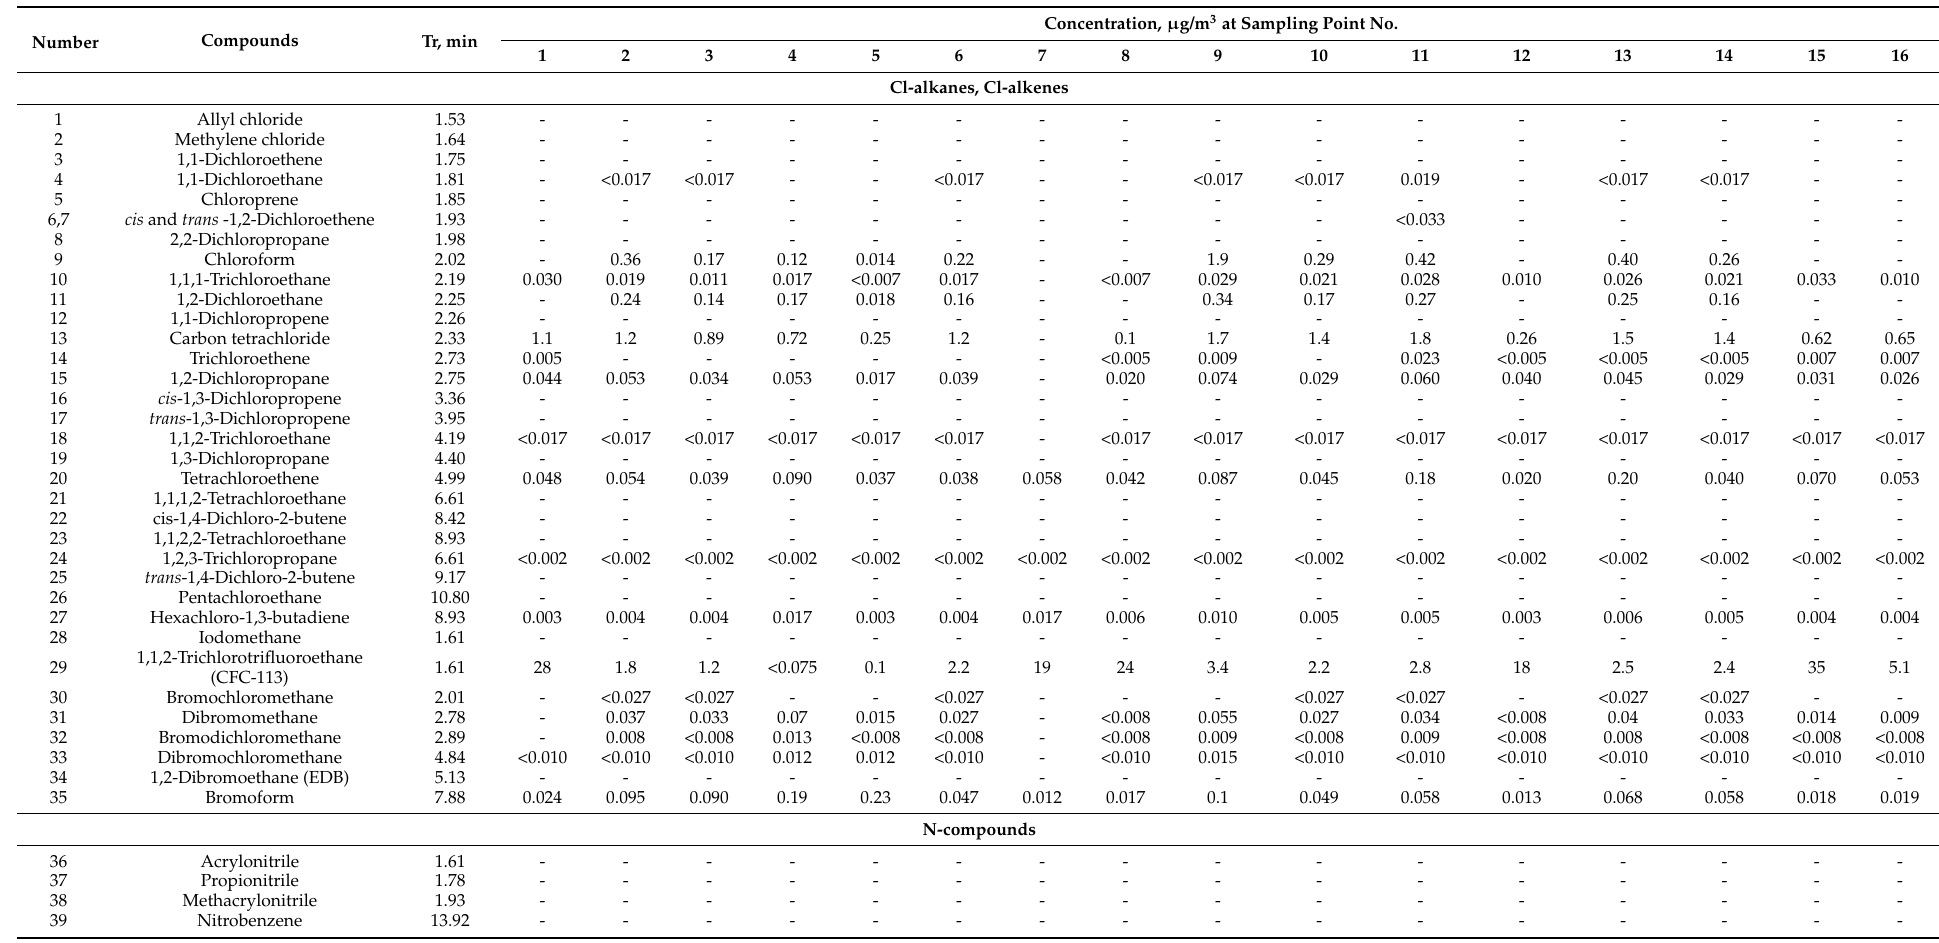
Table 1. Concentrations of volatile organic compounds in the air samples measured by